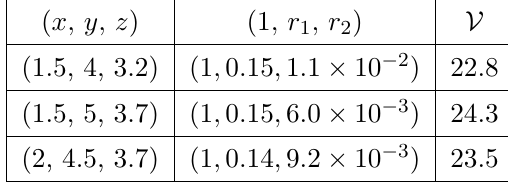
Table 2 . Benchmark ratios for the ratio (1 , r 1 , r 2 ) and the toroidal volume V at several moduli